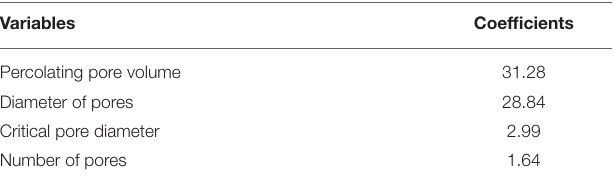
TABLE 4 | Coefficient values from the most relevant variables used for the PLSR describing the evolution of soil hydraulic conductivity at saturation ( Ksat